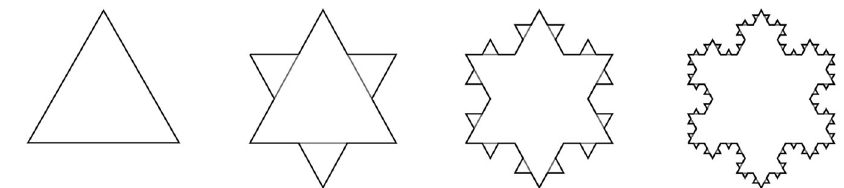
Fig. 1 Koch snow fl ake created in 4 iterations. The snow fl ake is created on the basis of an equilateral triangle, then by dividing each side of the triangle into three equal segments and replacing the middle segment with a smaller equilateral triangle. The process is repeated, theoretically to in fi nity but in practice until the sides can no longer be divided. Source: Image adapted from Wikimedia-Koch snow fl ake. This fi gure is covered by the Creative Commons Attribution-Share Alike 3.0 Unported (CC BY-SA 3.0). https://commons.wikimedia.org/wiki/File:KochFlake.svg [Accessed: